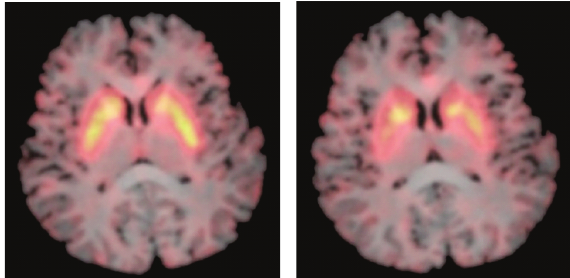
Figure 1: MRI scan with superimposed FMT PET K i images showing tracer uptake in caudate and putamen at two di ff erent axial